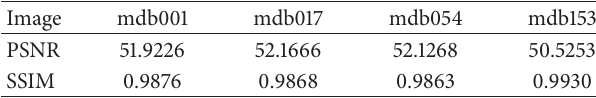
Table 1: Evaluation metrics of proposed algorithm.